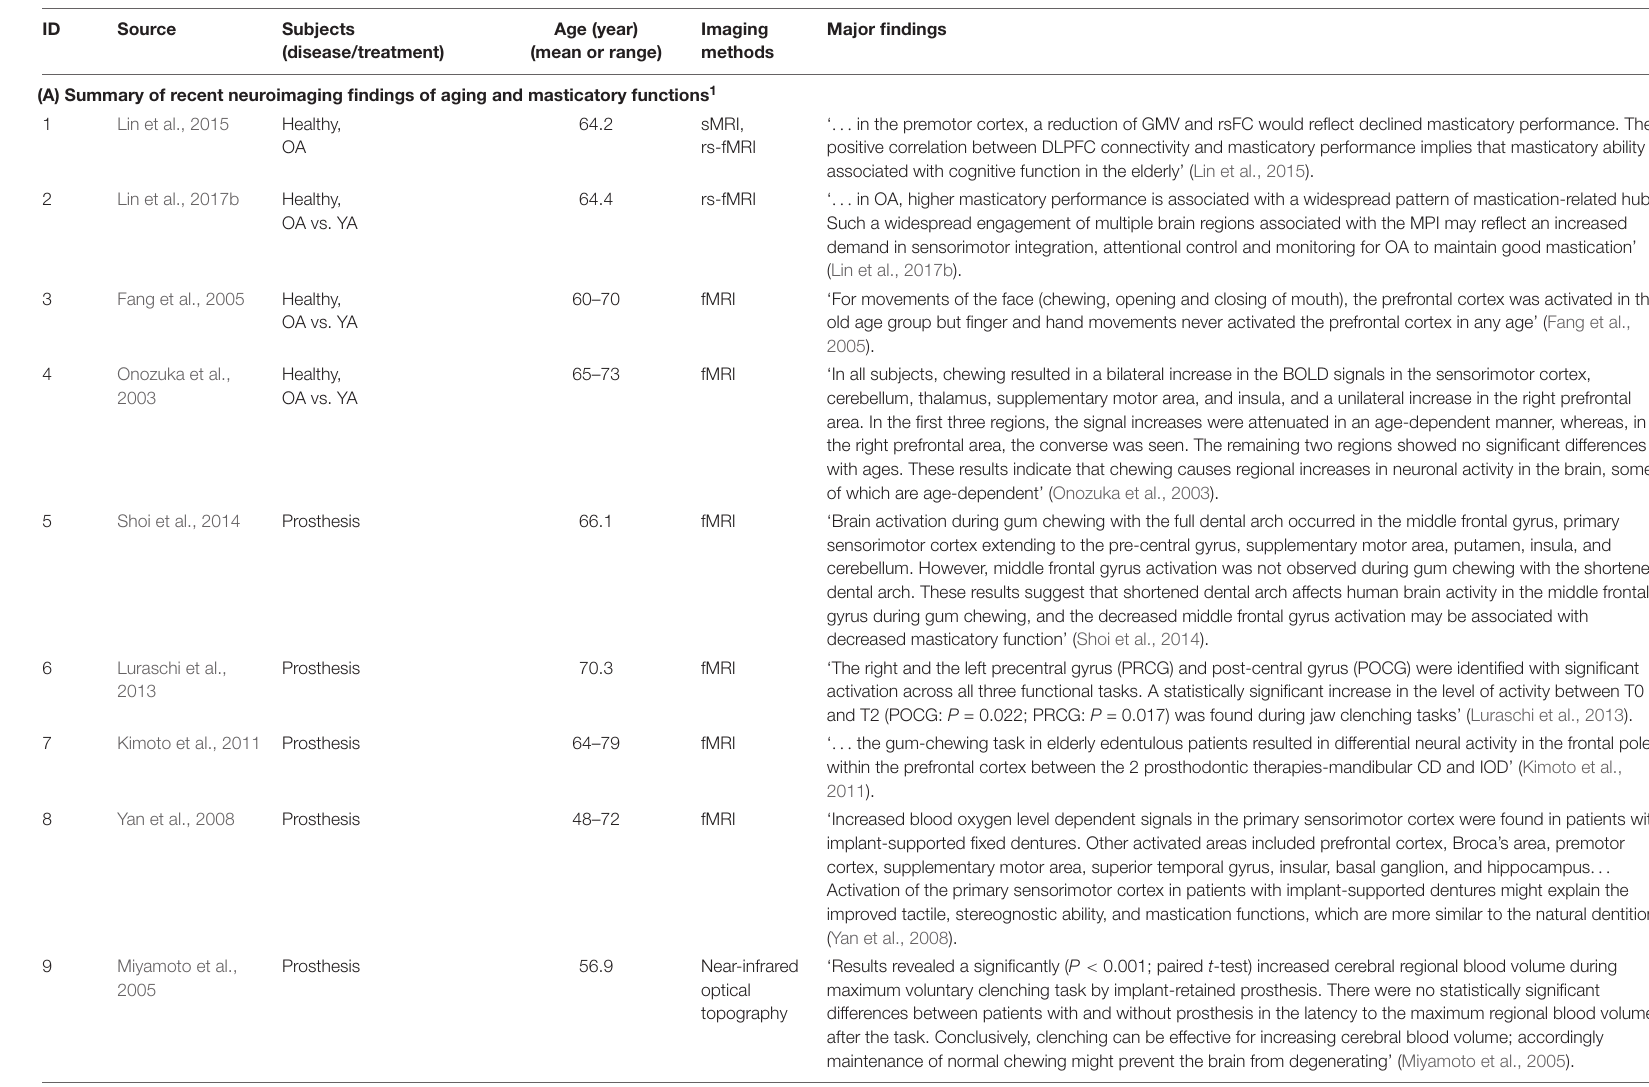
TABLE 1 | Results of literature search of the recent neuroimaging findings (from 2000 January 1 to present) of aging and oromotor functions. ID